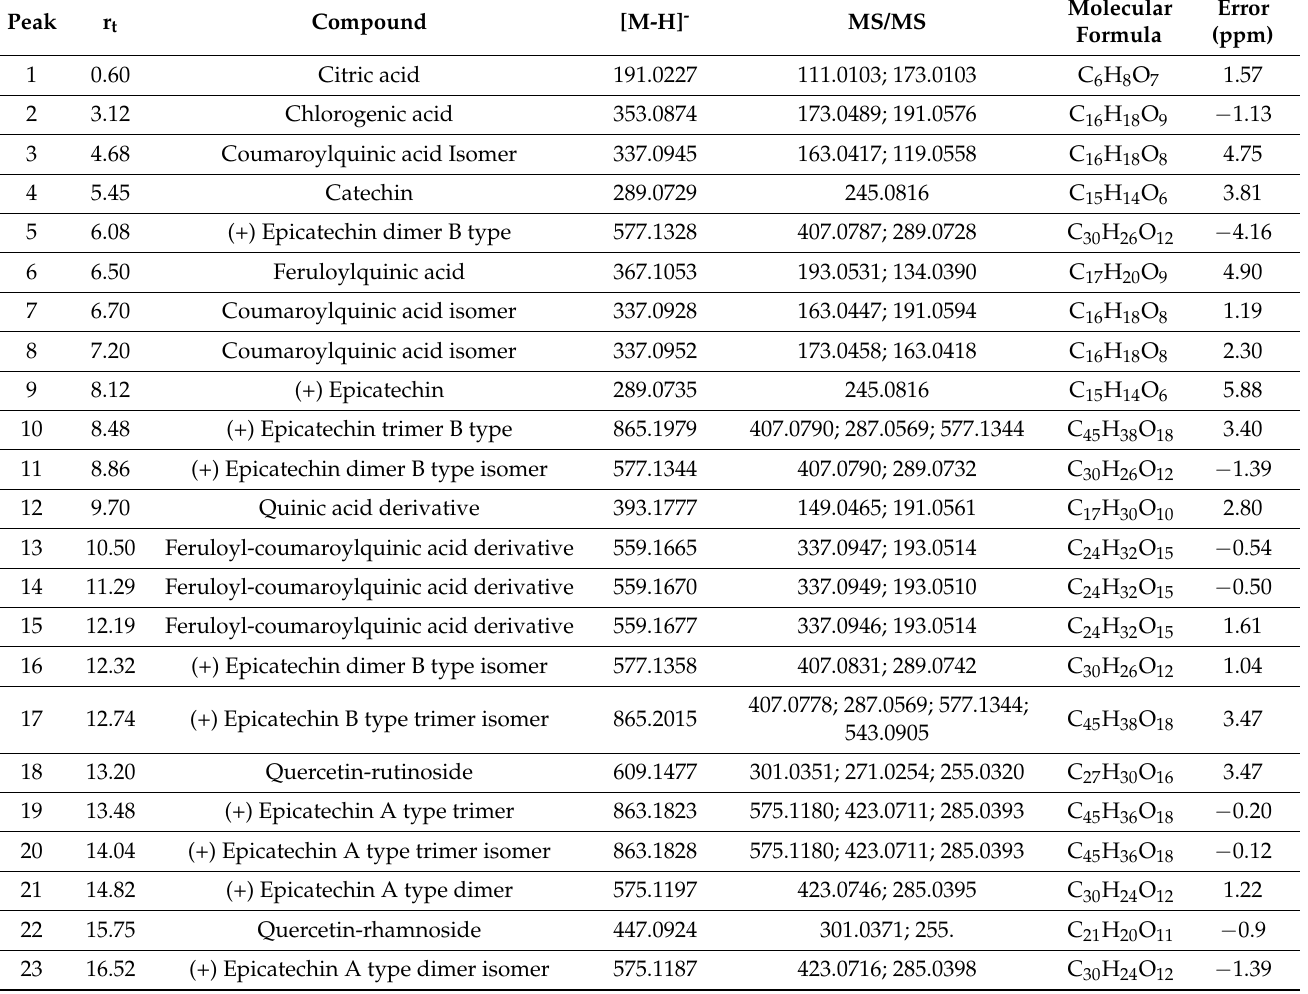
Table 3. Identified compounds in P. domestica subsp. syriaca fruit pulp extract according to the retention time (RT), compound, m/z and MS/MS, molecular formula, and mass accuracy, reported as part per million (ppm) error.